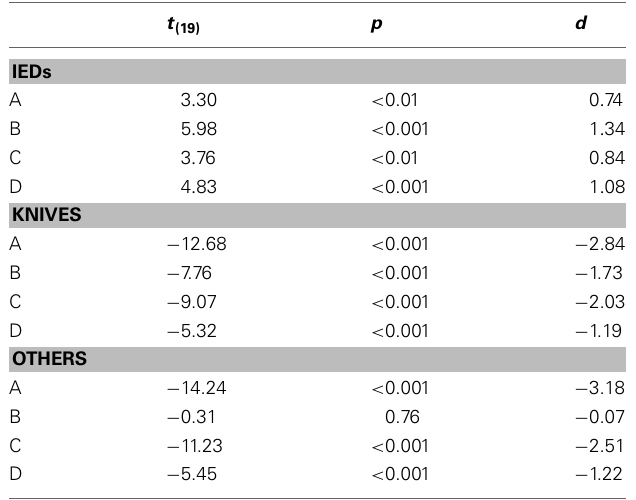
Table 3 | Results of two-tailed paired samples t -tests comparing the detection performance A’ with regard to the placement of each threat item (in laptop vs. in bag) for each threat category (guns, IEDs, knives, others) and each condition (A–D).